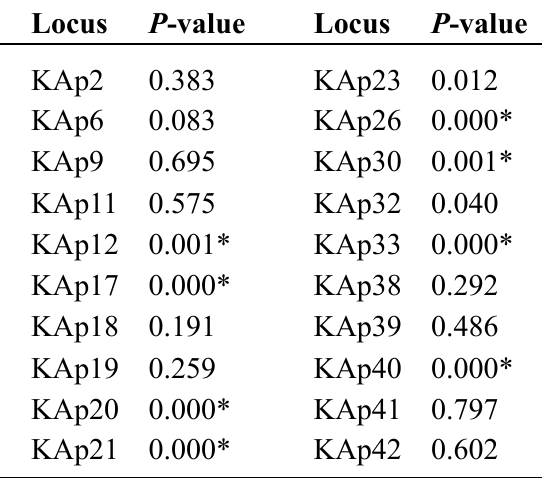
Table 3 . Comparison of allele frequencies between the wild and hatchery populations at 20 microsatellite loci of Atrina pectinata .